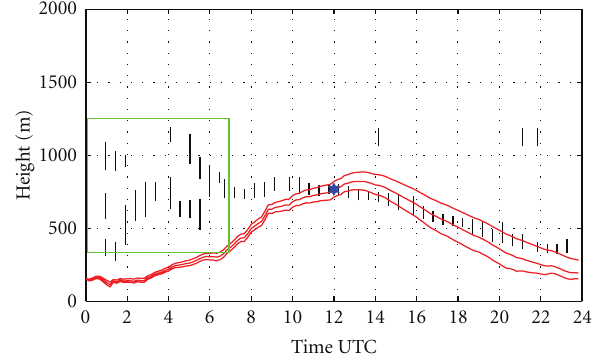
Figure 5: The PBL height as obtained from the Batchvarova and Gryning model (red line) and radiosonde (blue star) for 14 June 2010. The three red lines correspond to di ff erent w s values, as discussed in the text. Black lines indicate the top of the aerosol layers, as detected by the DWT on lidar data, showing the associated indetermination. The aerosol layers enclosed in the green box are associated to hazy layers that likely do not mark o ff the